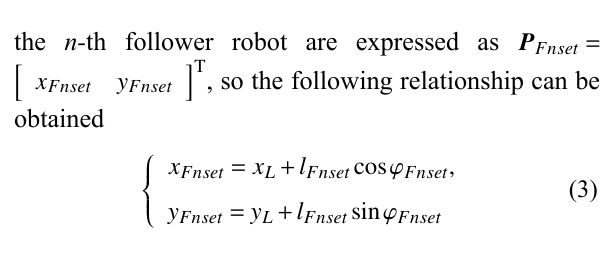
Fig. 3 Positional relationship between the leader robot and the follower